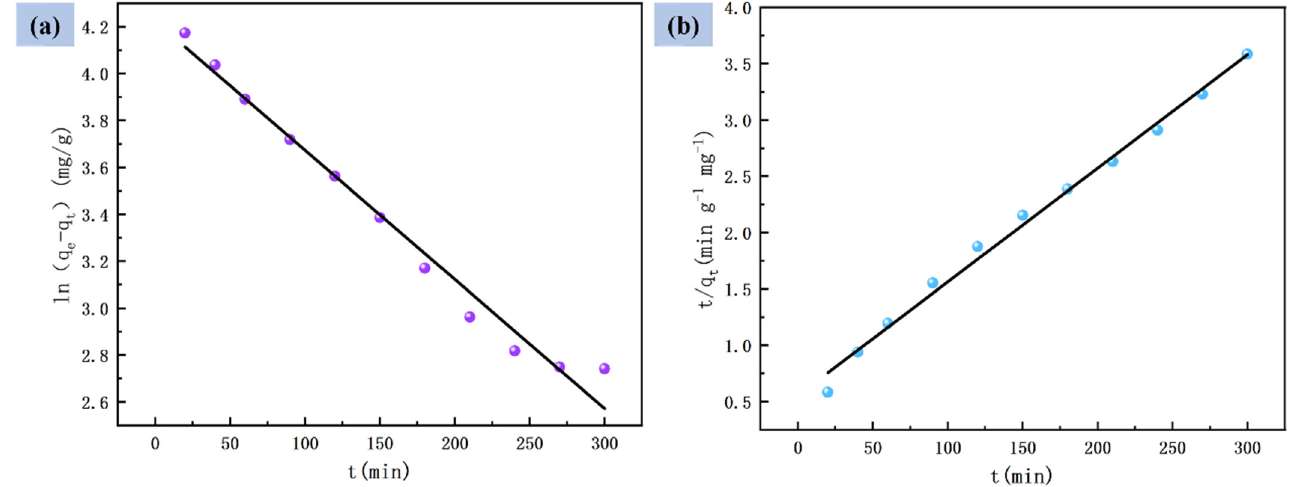
Figure 7. ( a ) Pseudo-first-order kinetic model and ( b ) pseudo-second-order kinetic model. Table 1. Comparison of kinetic parameters between the pseudo-first-order and pseudo-second-order models for Cr(VI) adsorption with PVDF–2GO@GO